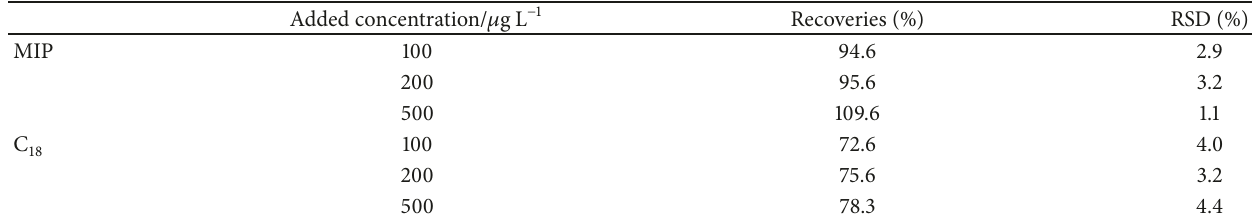
Table 5: Recoveries and RSDs of SPE-HPLC method for the spiked milk samples.